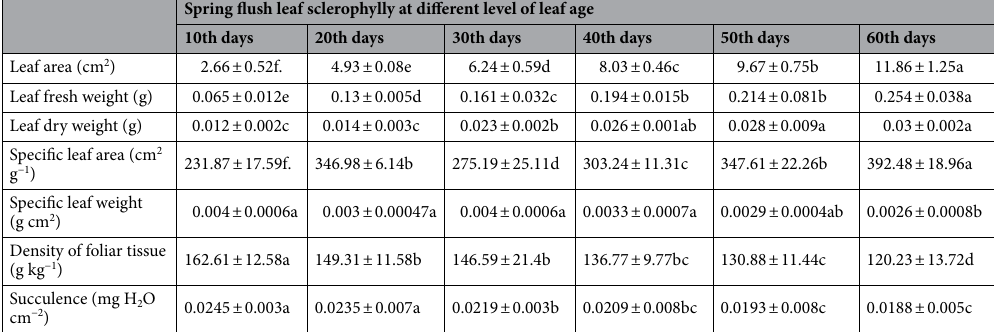
Table 8. Leaf sclerophylly parameters of spring flush.